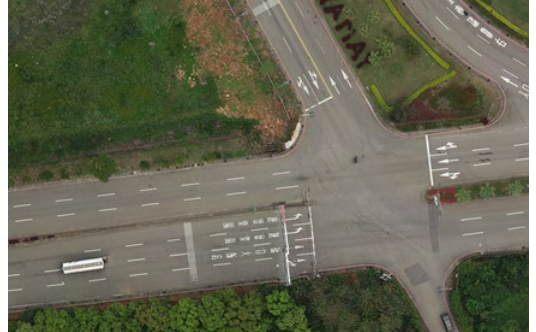
Figure 7. Aerial photograph